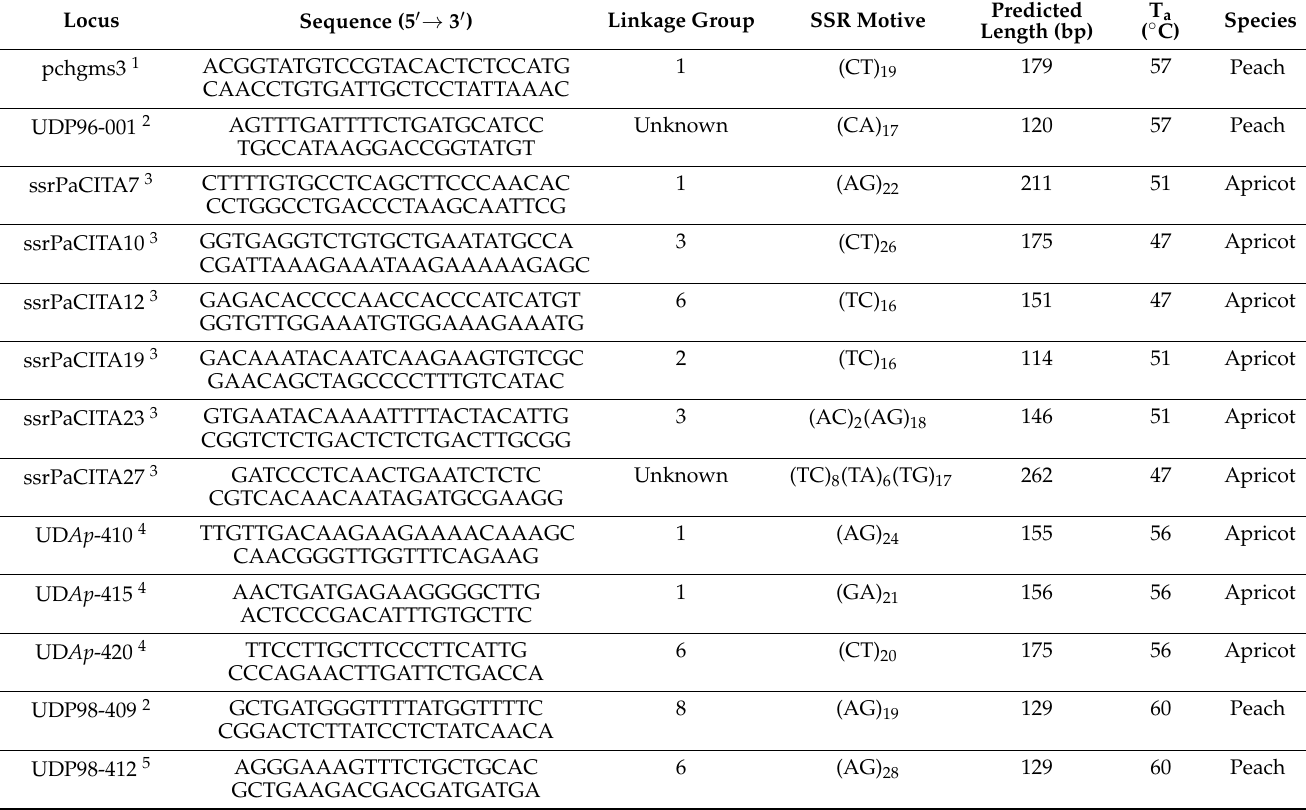
Table 2. List of the 13 apricot SSR loci from different Prunus species, primer sequences, linkage group, SSR motive, predicted length, and annealing temperature (T a ) used in this